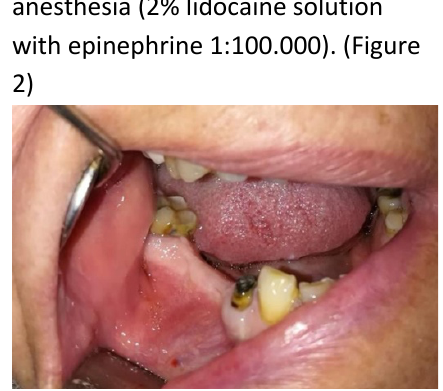
Figure 2. Initial intraoral image before the alveolar osteogenic distraction.